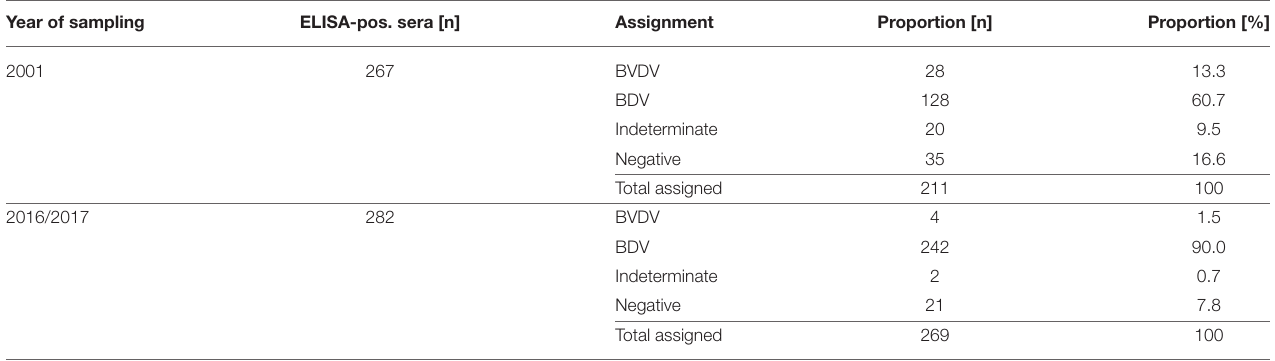
TABLE 5 | Differentiation of antibodies in sheep sera collected in 2001 and 2016/2017 by cross-SNT. Year of sampling